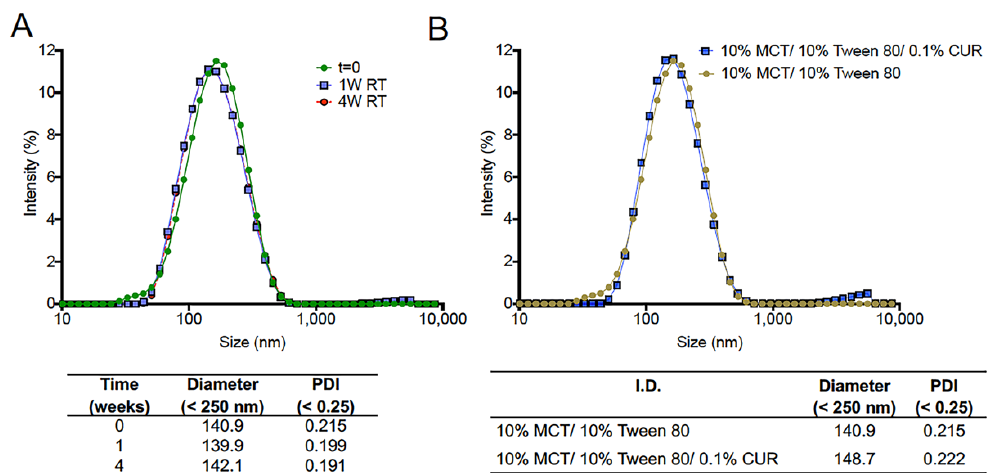
Figure 4. Size distribution follow up over time for nanoemulsions prepared during pre-formulation studies. ( A ) Droplet size and PDI comparison of 10% MCT oil/10% Tween 80 nanoemulsions up to 1 month at room temperature and ( B ) droplet size distribution comparison of 10% MCT oil/10% Tween 80 vs. 10% MCT oil/10% Tween 80/0.1% CUR nanoemulsions.